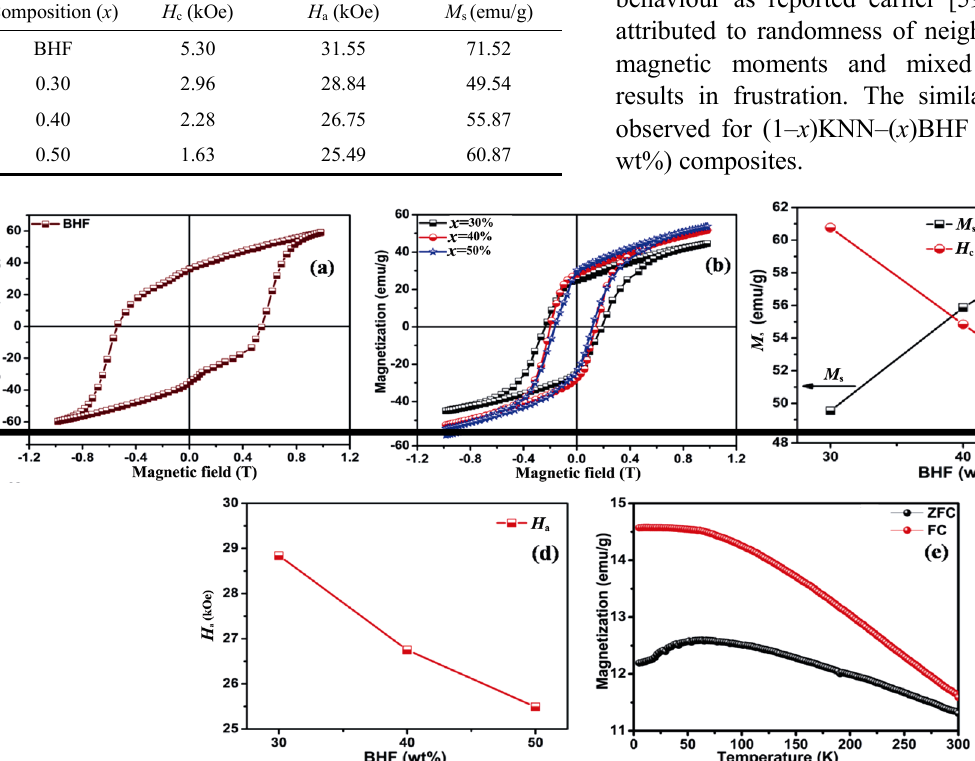
Fig. 9 M – H hysteresis loops for (a) BHF, (b) (1 ̶ x )KNN–( x )BHF ( x = 30, 40, and 50 wt%) composites, (c) variation of saturation magnetization ( M s ) and coercive field ( H c ), (d) anisotropy field ( H a ) of composites with BHF weight percentage, and (e) magnetization vs. temperature plot for pure